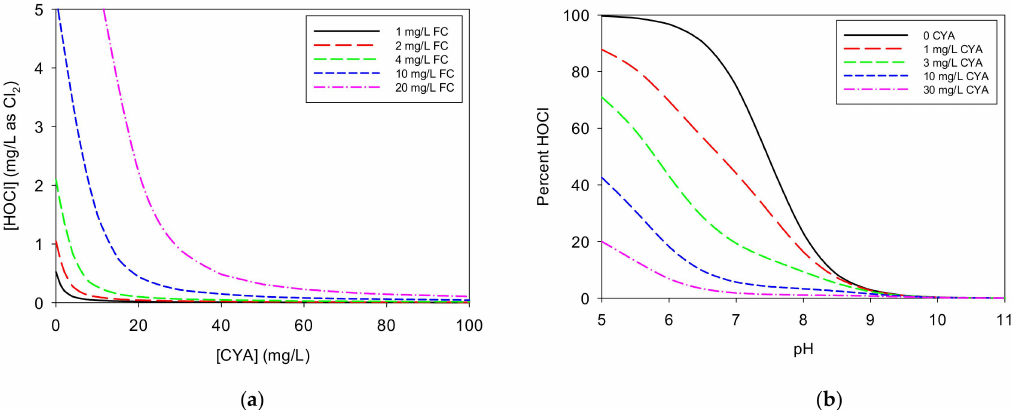
Figure 2. ( a ) Impact of cyanuric acid (CYA) on HOCl concentration for various concentrations of free chlorine (FC): The curves were calculated using a pH of 7.5. Ionic strength was not taken into account, as it would have little impact on the shapes of the curves. ( b ) Impact of pH on HOCl concentration for various concentrations of CYA: The curves were calculated using 1.0 mg / L of FC.